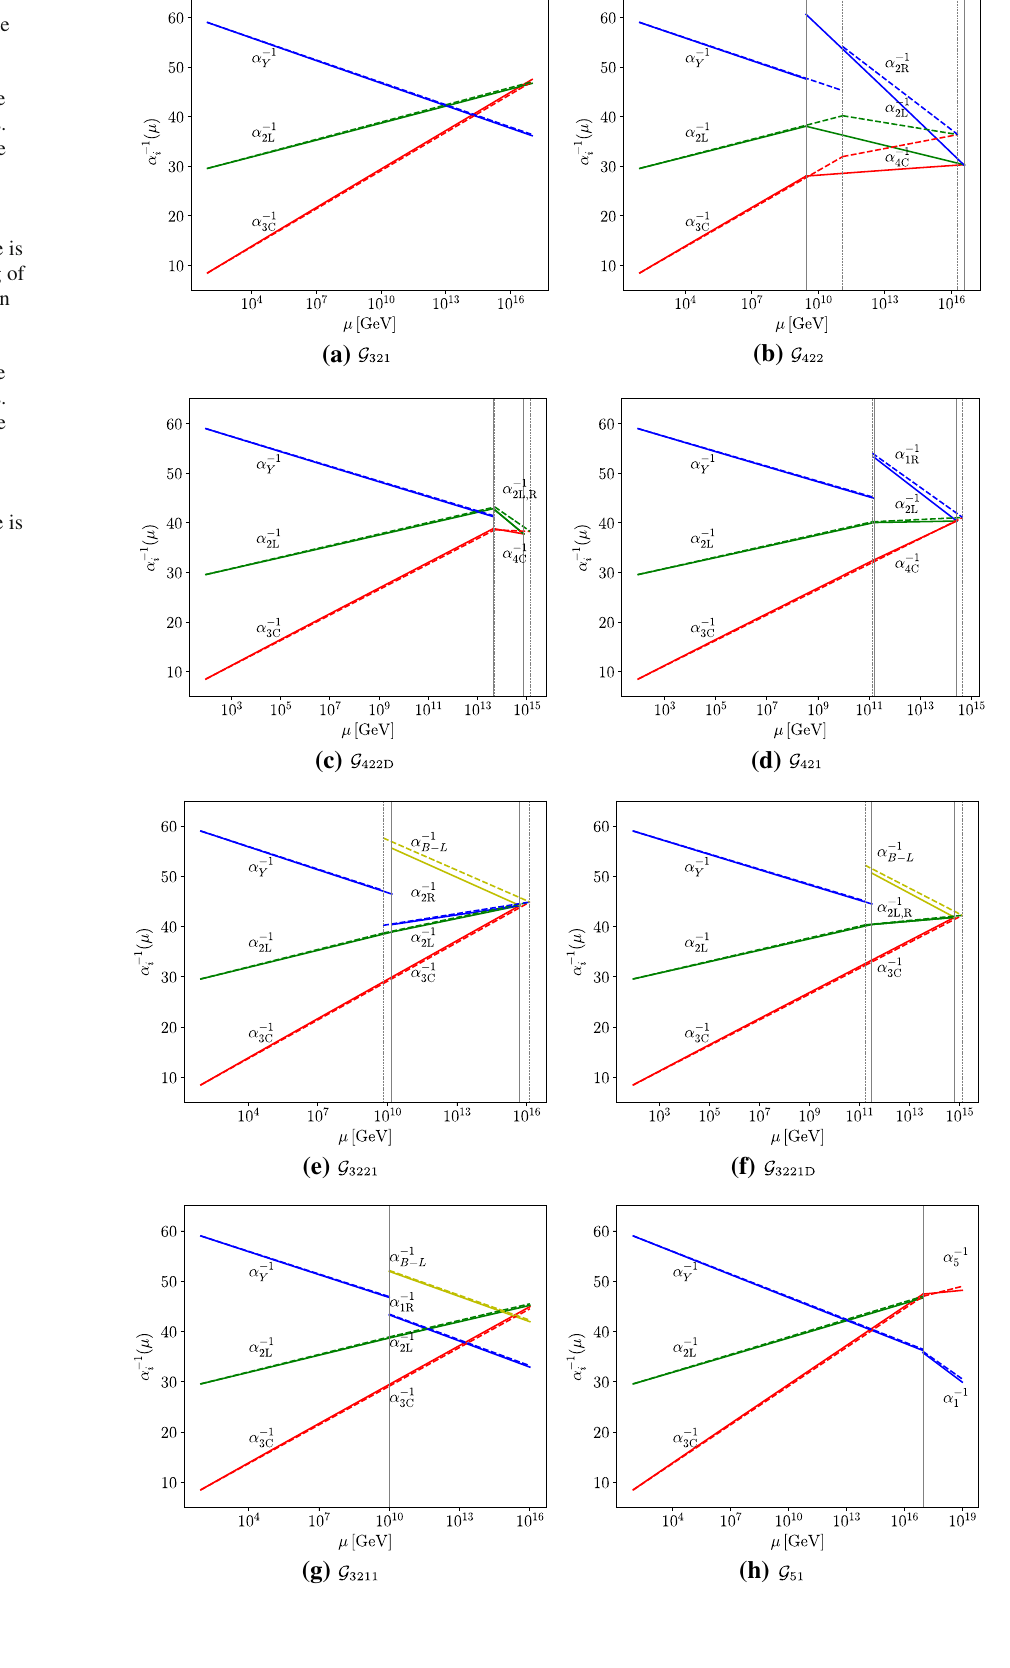
Fig. 1 RG running of the inverse gauge couplings in the eight different models considered. The results to two-loop (one-loop) order are shown as solid (dashed) lines. For the models without gauge coupling unification, representative values for the scales were chosen. GUT normalization of hypercharge is used throughout.